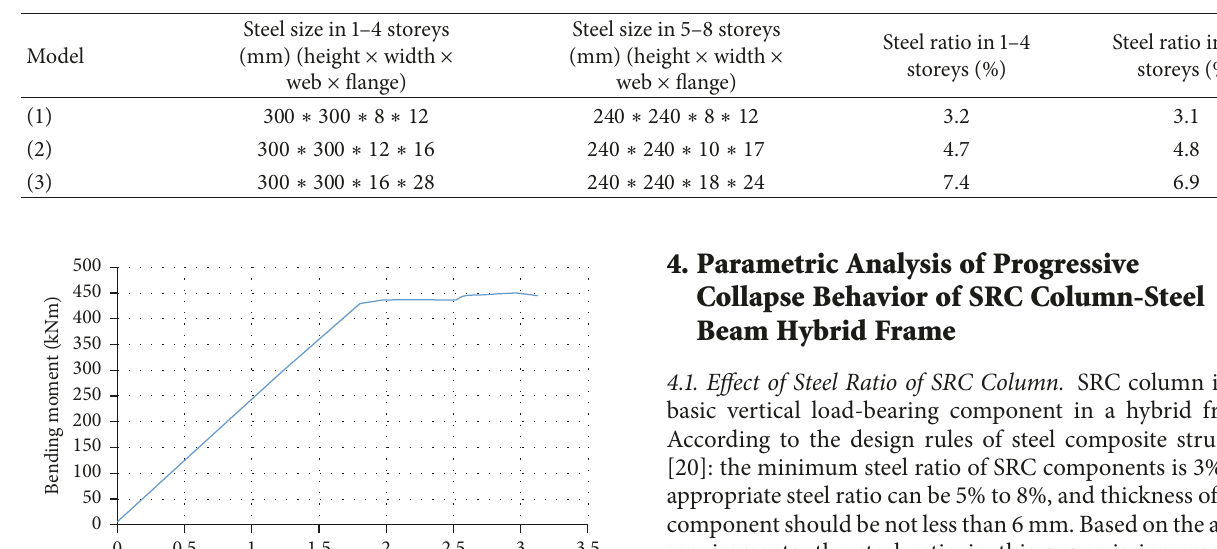
Table 2: Different SRC column-steel ratio parameters for models ( 1 )–( 3 ).